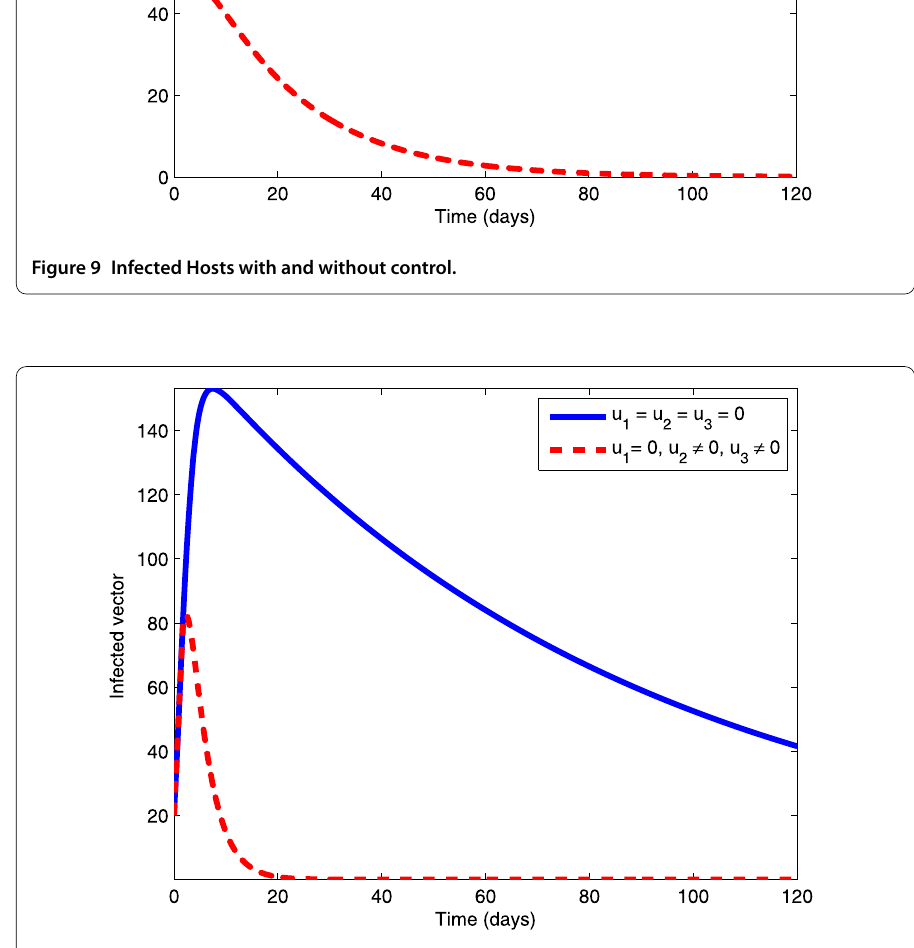
Figure 10 Infected Vectors with and without